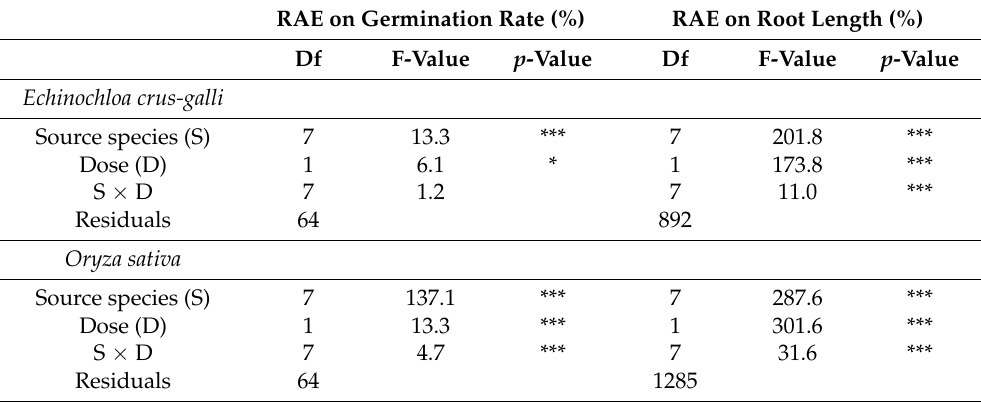
Table 1. Results of two-way ANOVAs testing for the effects of aqueous extracts’ source species ( Aegiceras corniculatum , Avicennia marina , Lumnitzera racemosa , Bruguiera gymnorhiza , Kandelia obo- vata , Rhizophora stylosa , Sonneratia apetala and S. caseolaris ), dose (2.5 and 5%) and their interactions on the Relative Allelopathic Effects (RAEs) on seed germination ( n = 80 boxes) and root length ( n = 908–1301 seedlings) of the two target species ( Echinochloa crus-galli and Oryza sativa ) 10 days after germination (Df: degrees of freedom; p -values are indicated with the respective symbols, * p < 0.05 and *** p <